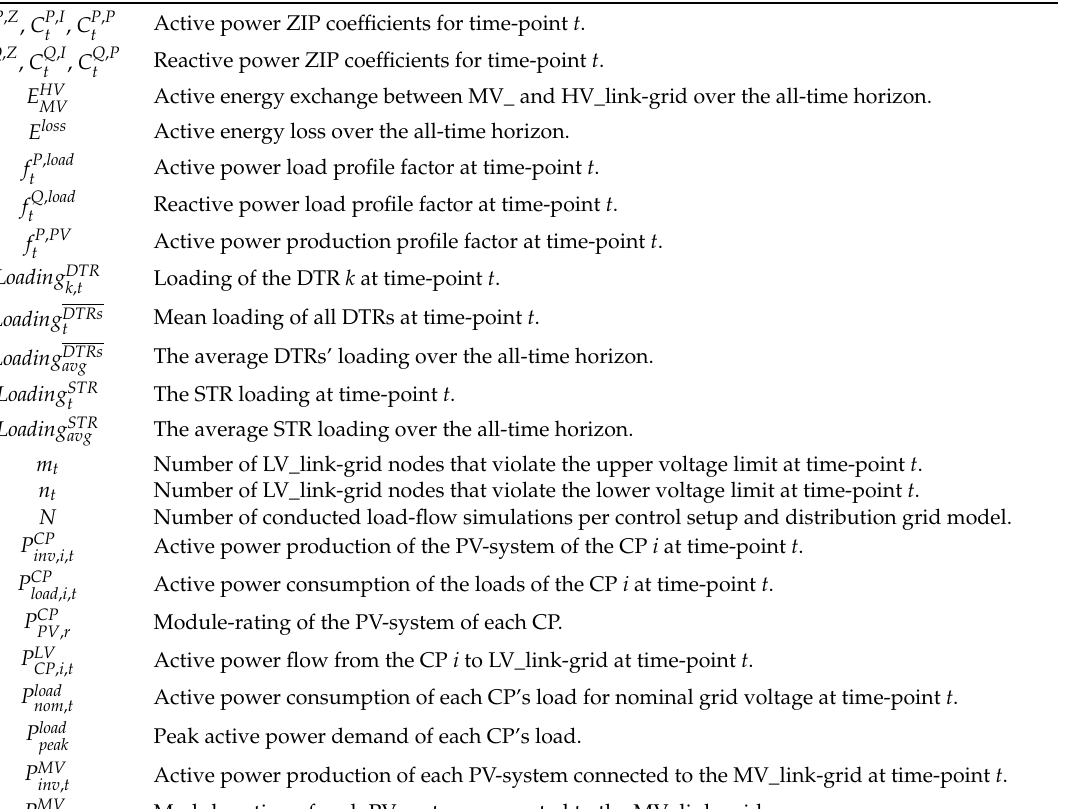
Table A2 lists the nomenclature of all variables used for calculations. Table A2. Nomenclature of all variables used for